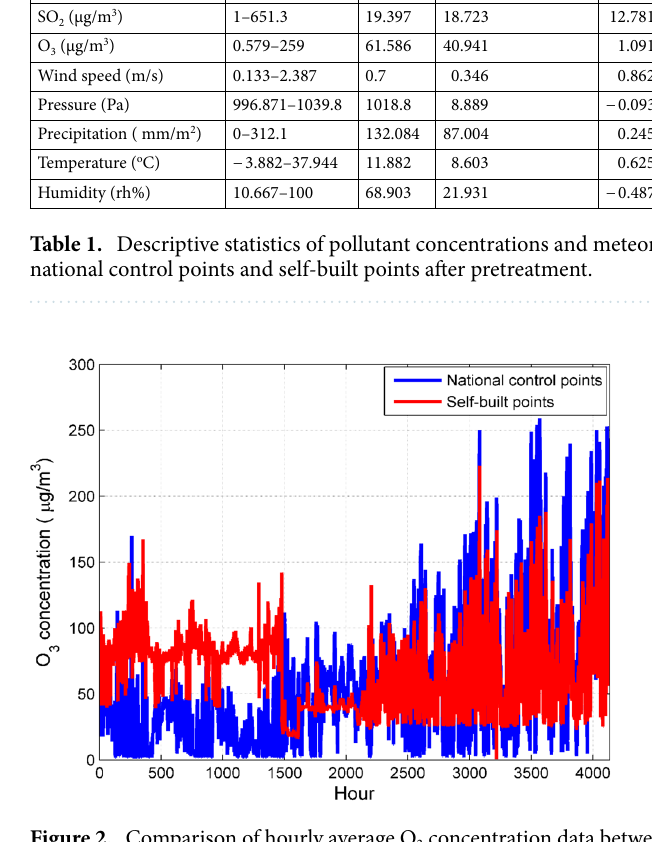
Figure 2. Comparison of hourly average O 3 concentration data between national control points and self-built points. Figures are generated using Matlab (Version R2016a, https:// www. mat- hworks.com/)